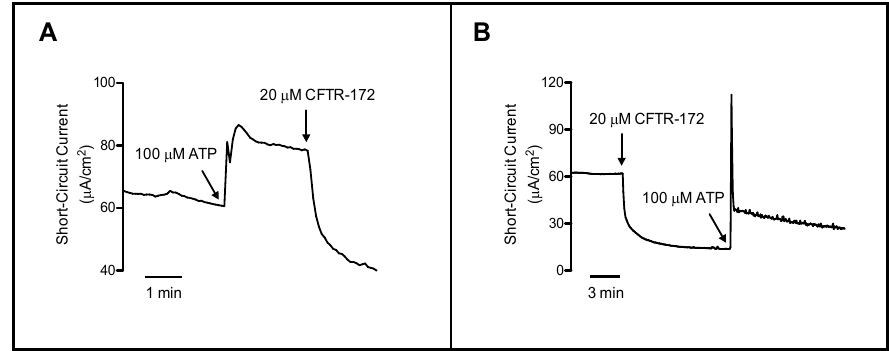
Figure 1. Presence of Cystic Fibrosis transmembrane conductance regulator (CFTR) and non-CFTR mediated Cl − secretion in normal rat tracheal epithelium. Chloride secretion was measured as short-circuit current (I SC ) in tracheal epithelia that were mounted under voltage clamp condition. ( A ) Effect of CFTR-172 inh (CFTR inhibitor; 20 μM) on ATP stimulated Cl − secretion. Mucosal ATP (100 μM) addition stimulates Cl − secretion that consists of two components—the sharp initial increase in I SC immediately followed by a second, more rounded and prolonged current. Inhibition by mucosal CFTR-172 inh (CFTR inhibitor) indicates that the ATP-stimulated sustained Cl − secretion is mediated by CFTR. The CFTR-172 inh inhibition of I SC below baseline indicates that CFTR also accounts for a portion of basal Cl − secretion in normal trachea. ( B ) Effect of ATP on Cl − secretion in CFTR-172 inh pre-incubated trachea. In CFTR-172 inh pre-incubated trachea, mucosal ATP (which transiently increases intracellular Ca 2+ ) transiently stimulates Cl − secretion with a minimal plateau phase of Cl − secretion. The transient Cl − secretion represents non-CFTR mediated Cl − secretion (i.e., through TMEM16A). The presence of a residual plateau phase of Cl − secretion may likely be attributable to CFTR activation in response to ATP, which cannot be completely inhibited by 20 μM CFTR-172 inh . (The unpublished data presented in this figure is in good agreement with the literature).